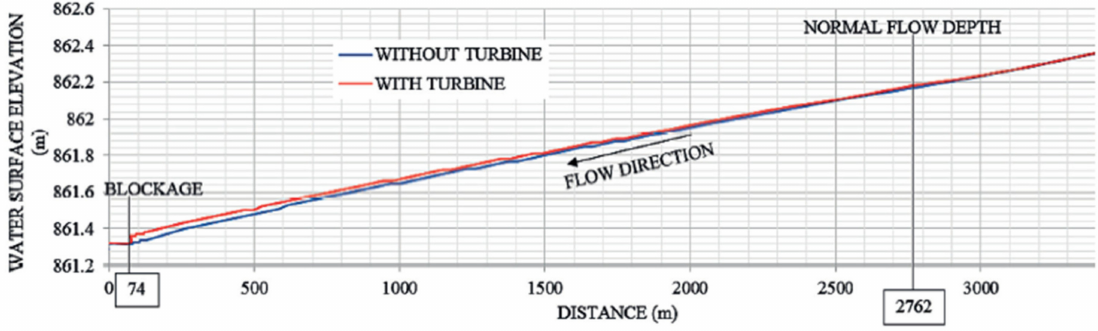
Figure 3. Backwater effect due to turbine blockages